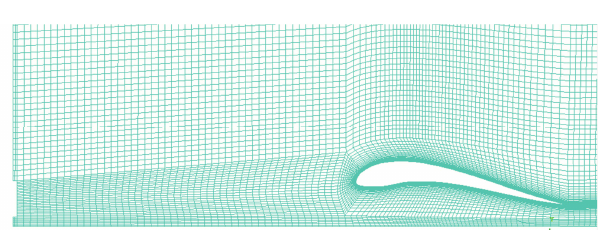
Fig. 4. View of mesh for WIG effect simulation with exhaust gasses redirection to the lower surface of